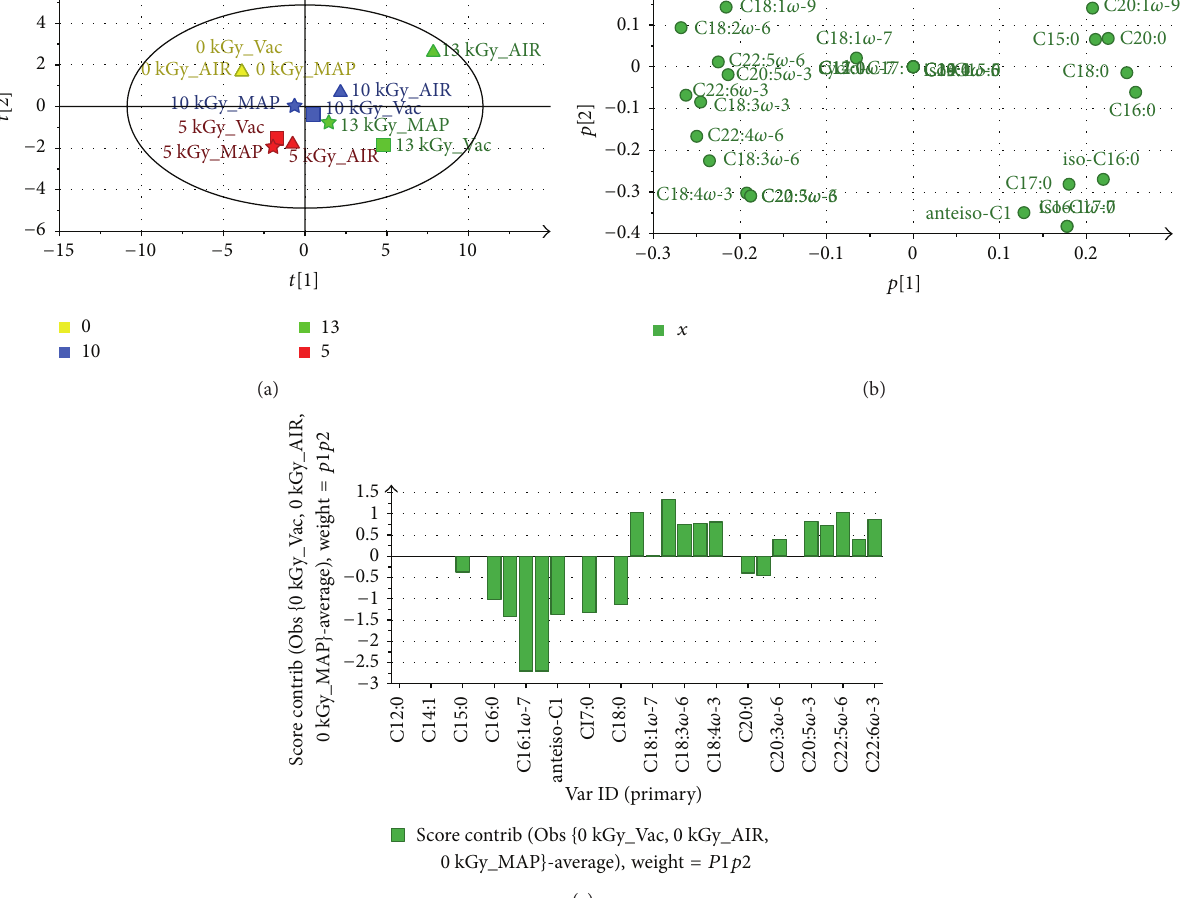
: 71.5%, and 𝑄 2 X 1,2 ( : 37.1%. Samples cum ) cum )